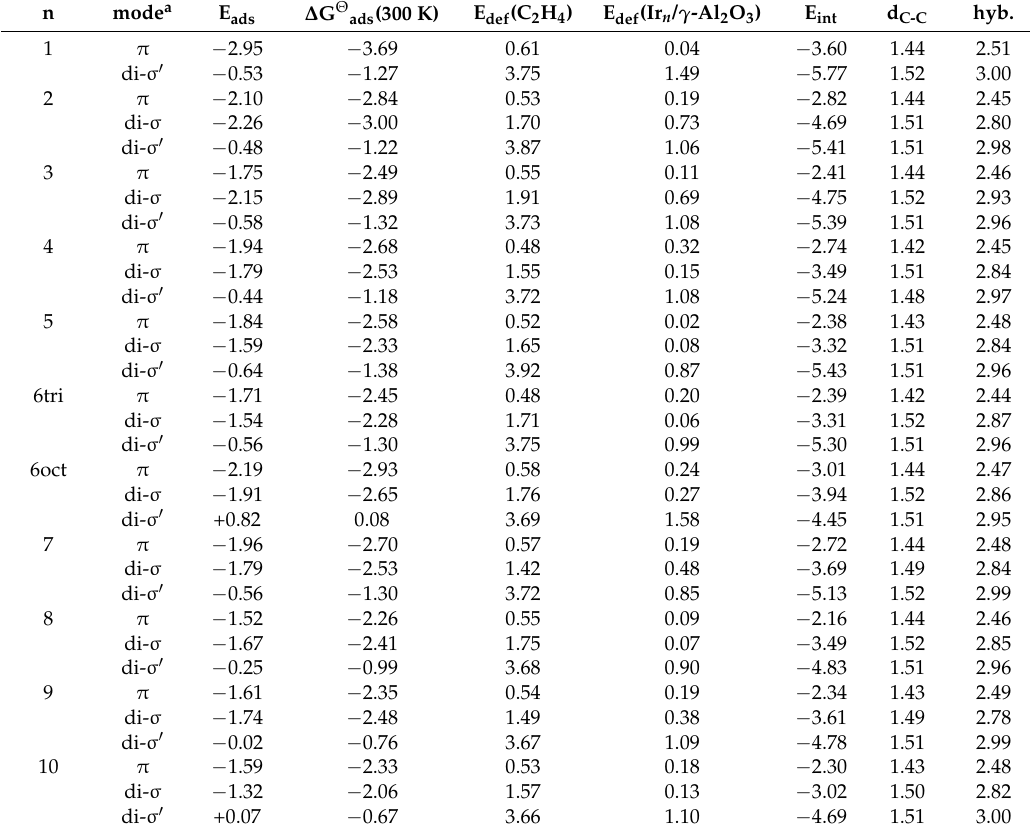
Table 2. Adsorption energy E ads (eV), standard adsorption Gibbs free energy at 300 K with the partial pressure of ethylene at 1atm ∆ G Θ ads (300 K) (eV), ethylene deformation energy E def (C 2 H 4 ) (eV), substrate deformation energy E def (Ir n / γ -Al 2 O 3 ) (eV), interaction energy E int (eV), carbon–carbon bond distance d C-C (Å), and mean hybridization value (hyd.) for ethylene adsorption on hydrated γ -Al 2 O 3 (110)-supported Ir n (n = 1–10)